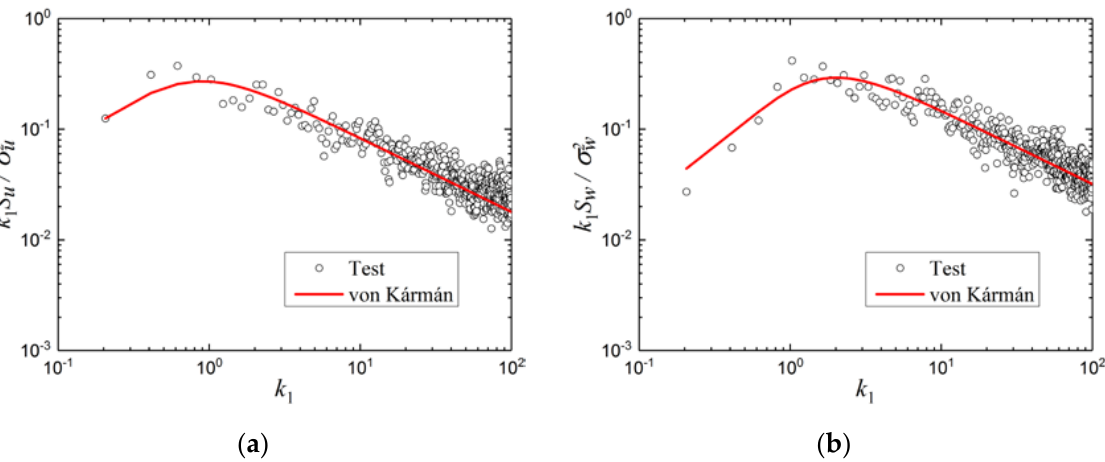
Figure 7. Longitudinal and vertical turbulence spectra in XNJD-3 spire turbulence field. ( a ) Longitudinal; ( b ) vertical. Table 1. Turbulence characteristics